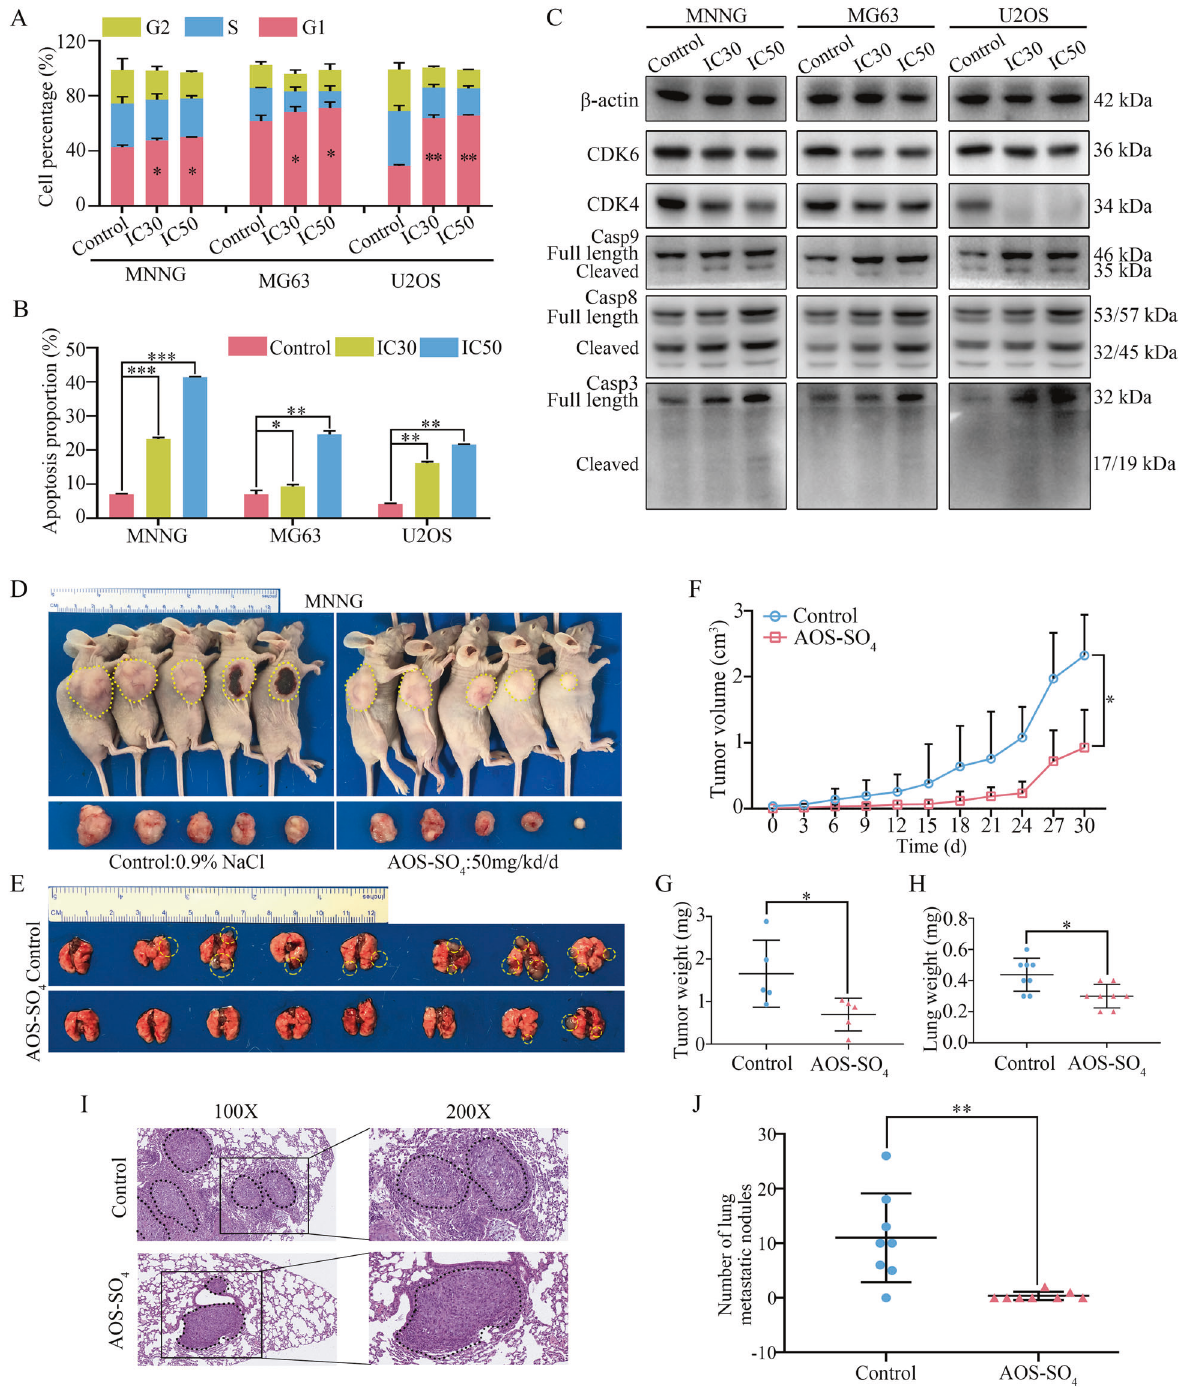
Fig. 3 AOS-SO 4 affects the osteosarcoma cell cycle and apoptosis in vitro and inhibits osteosarcoma cell growth and metastasis in vivo. A Flow cytometry histograms of the cell cycle in each phase after treatment with AOS-SO 4 showing G1 phase arrest. B Flow cytometry histograms of cell apoptosis distribution after treatment with AOS-SO 4 for 48 h. C After treatment with AOS-SO 4 , proteins were extracted from three cultured osteosarcoma cells and probed with appropriate dilutions of speci fi c antibodies. Representative results of CDK4, CDK6, full length and cleavage of caspase ‐ 9, ‐ 8, and ‐ 3 protein levels were determined by western blot analysis. D Photograph of tumor-bearing mice (injected by MNNG cell) and photograph of tumors after the mice were euthanized. E Lung metastasis formed by MNNG cells in the AOS-SO 4 treatment and control groups. F Growth curve drawn by measuring tumor volumes on the indicated days. G Diagram showing the tumor weights in the subcutaneous tumor model. H Diagram showing the lung weights in the control group and AOS-SO 4 treatment group. I HE staining of lung samples obtained from nude mice after injection with MNNG cells. J Statistical analysis of lung metastasis nodules in the AOS- SO 4 and control groups. Data are shown as the means ± SD from at least three independent experiments. Statistical analysis was performed using Student ’ s t -test. Error bars represent the SEM. * P < 0.05; ** P < 0.01; *** P <